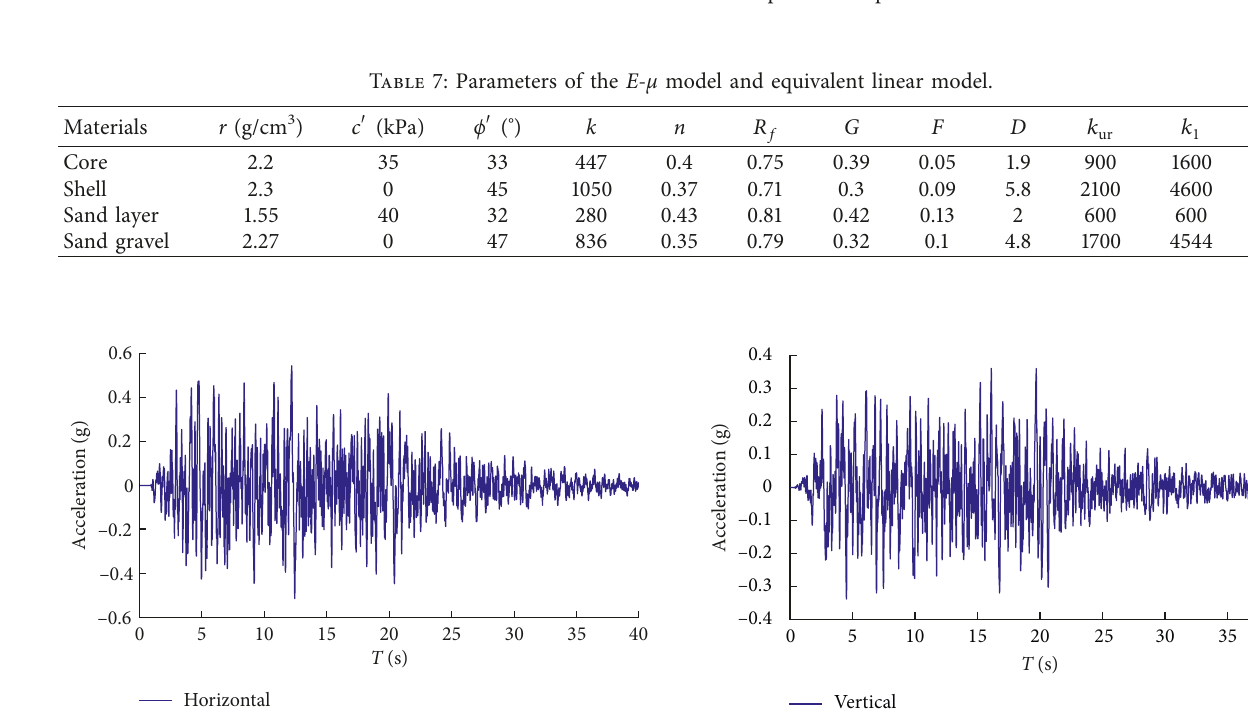
Figure 7: Cross section of the dam and potential slip surfaces.